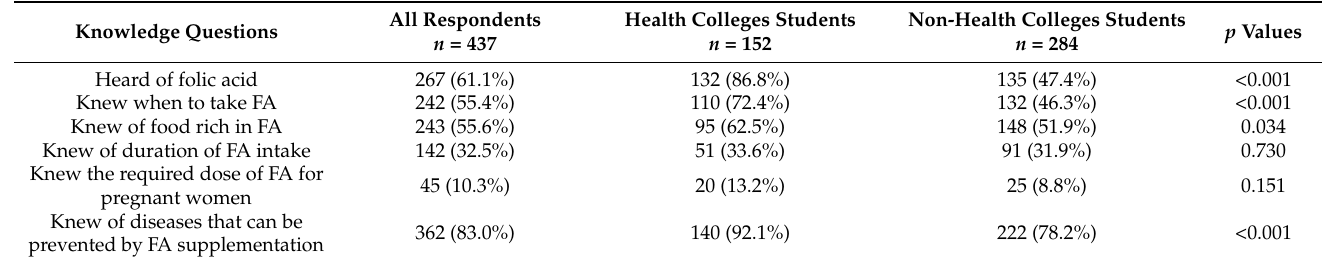
Table 2. Comparing the correct responses on the knowledge of FA, timing of intake, duration of intake, food sources of FA, dose of FA and diseases prevented by FA between health colleges and non-health colleges students ( n = 437).